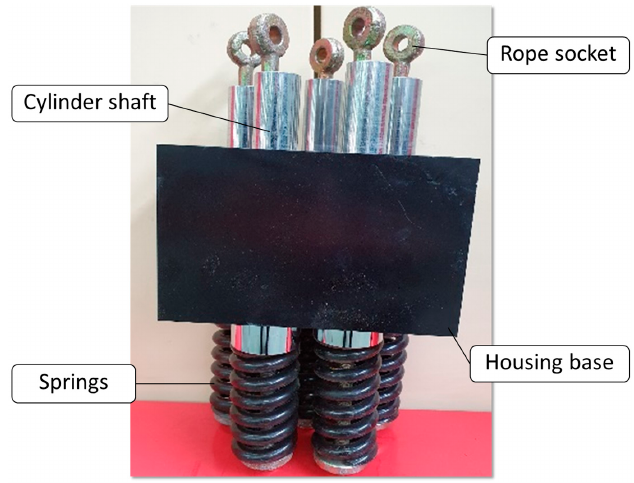
Machines 2022 , 10 , x FOR PEER REVIEW Figure 11. Photograph of the performance test prototype. Figure 11. Photograph of the performance test prototype.